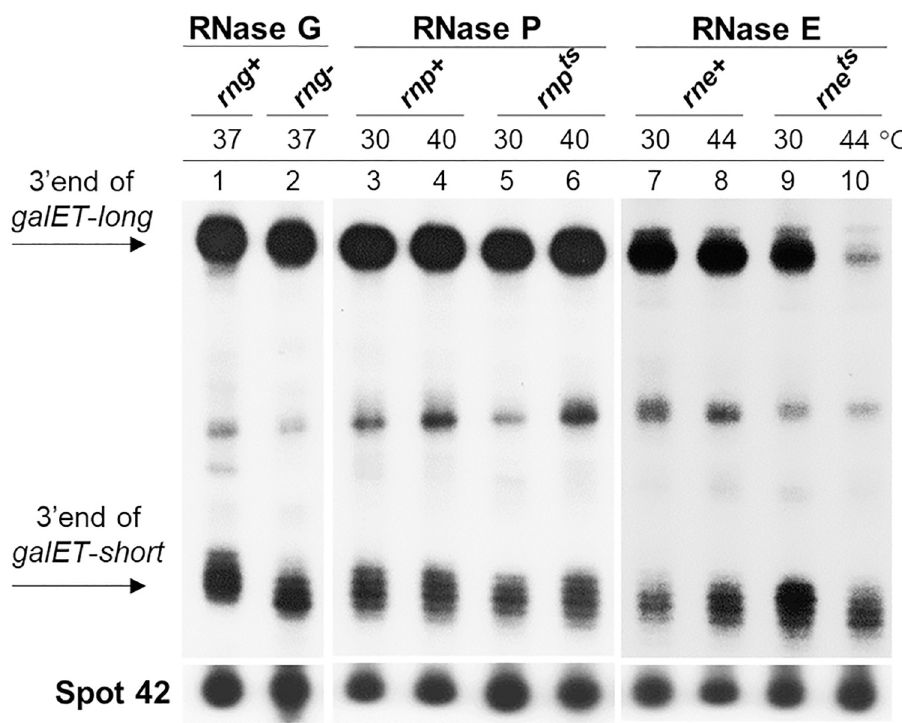
Fig 3. RNase E is involved in the generation of galET-long 3’ ends. 3’RACE assay of galET RNA 3’ ends in three different endoribonuclease mutant strains. Strains used are GW10 ( rng+ rne+ ; WT for RNase G and RNase E, lanes 1, 7 and 8), GW11 ( rng :: cat ; [ rng- ] RNase G down mutant, lane 2), NHY312 ( rnpA+ ; [ rnp+ ] WT for RNase P, lanes 3 and 4), NHY322 ( rnpA49 ; [ rnp ts ] RNase P temperature-sensitive mutant, lanes 5 and 6), GW20 ( ams1 ts ; [ rne ts ] RNase E temperature-sensitive mutant, lanes 9 and 10). The data presented in these blots are representative of three independent